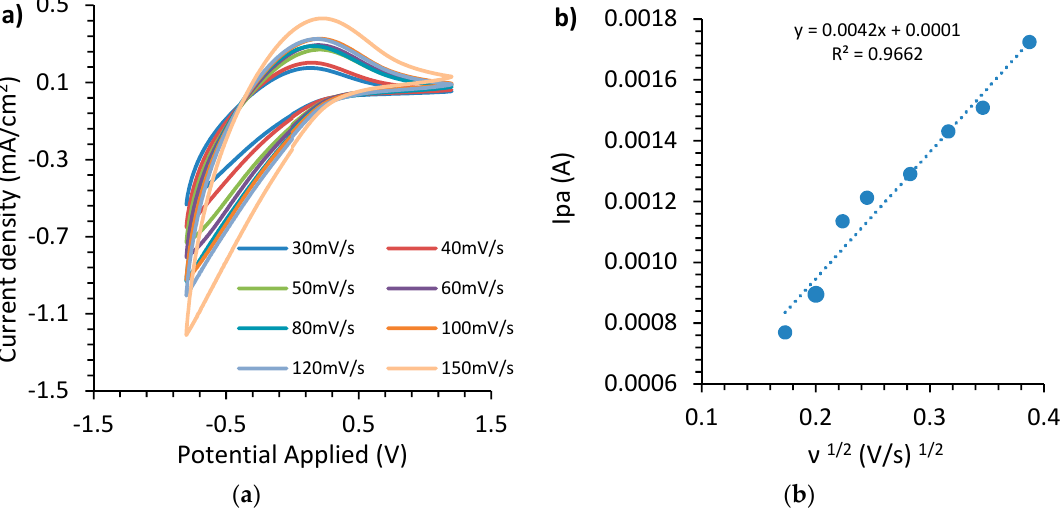
Figure 6. ( a ) Cerium-modified TiO 2 voltammetry curves at various scan rates, ( b ) plot of anodic peak current versus the square root of the scan rate.